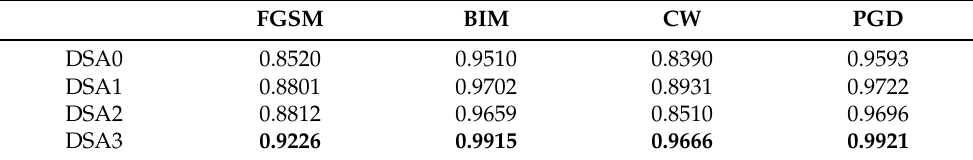
Table 2. AUC-ROC of DSA-based corner case data detection on adversarial data testing. FGSM BIM CW PGD DSA0